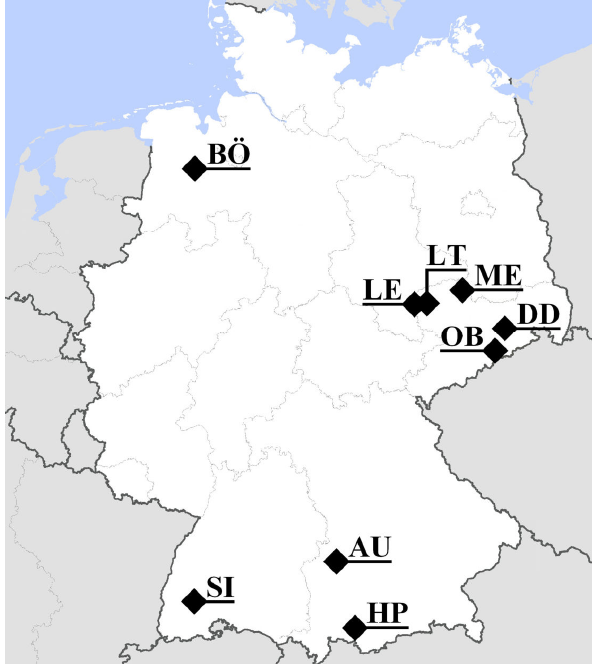
Fig. 2. Sampling sites (see Scheinhardt et al., 2013b). See text for coding